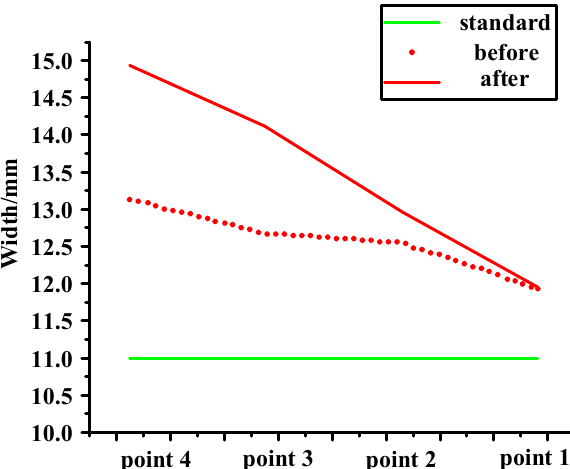
Figure 17. Original and add 1.4 mm .